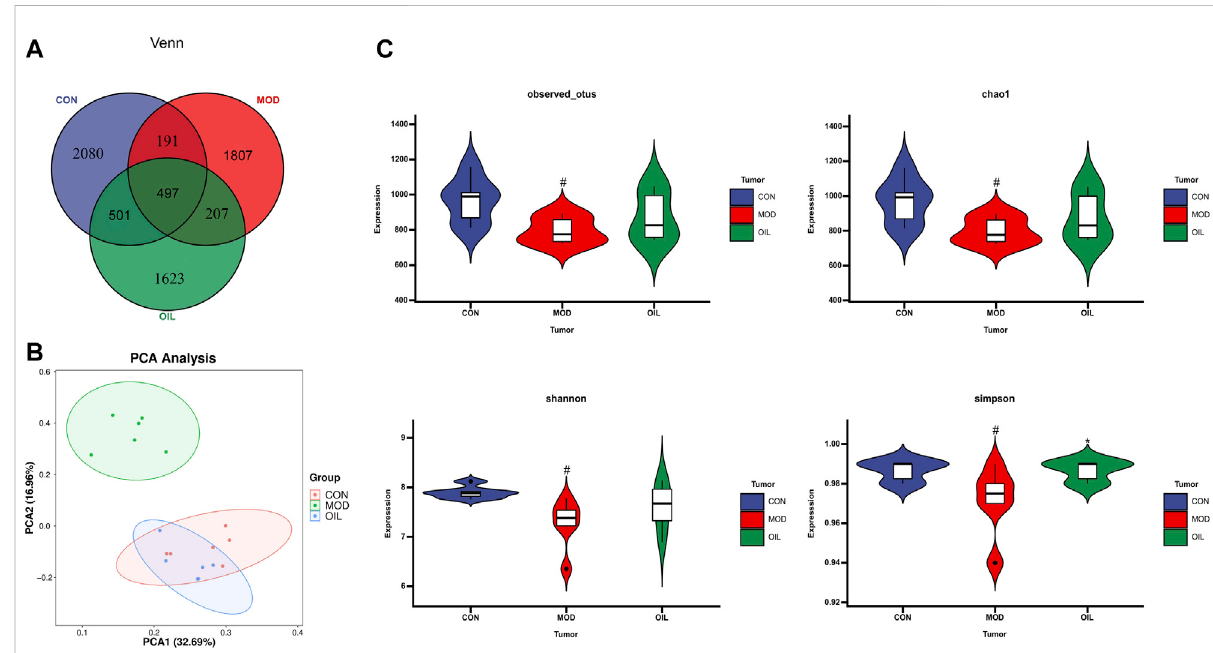
FIGURE 6 Venn diagram depicting the distribution of OTUs among different groups (A) . PCA score plot of control group, model group and Amygdalus mongolica oil group (B) . Intestinal microbial Alpha diversity of Chao1, Simpson, Shannon and Observed species in all groups (C) . Statistical signi fi cancewascalculatedwithANOVA.* p < 0.05and** p < 0.01comparedtothemodelcontrolgroup.# p < 0.05and## p < 0.01comparedtothe control